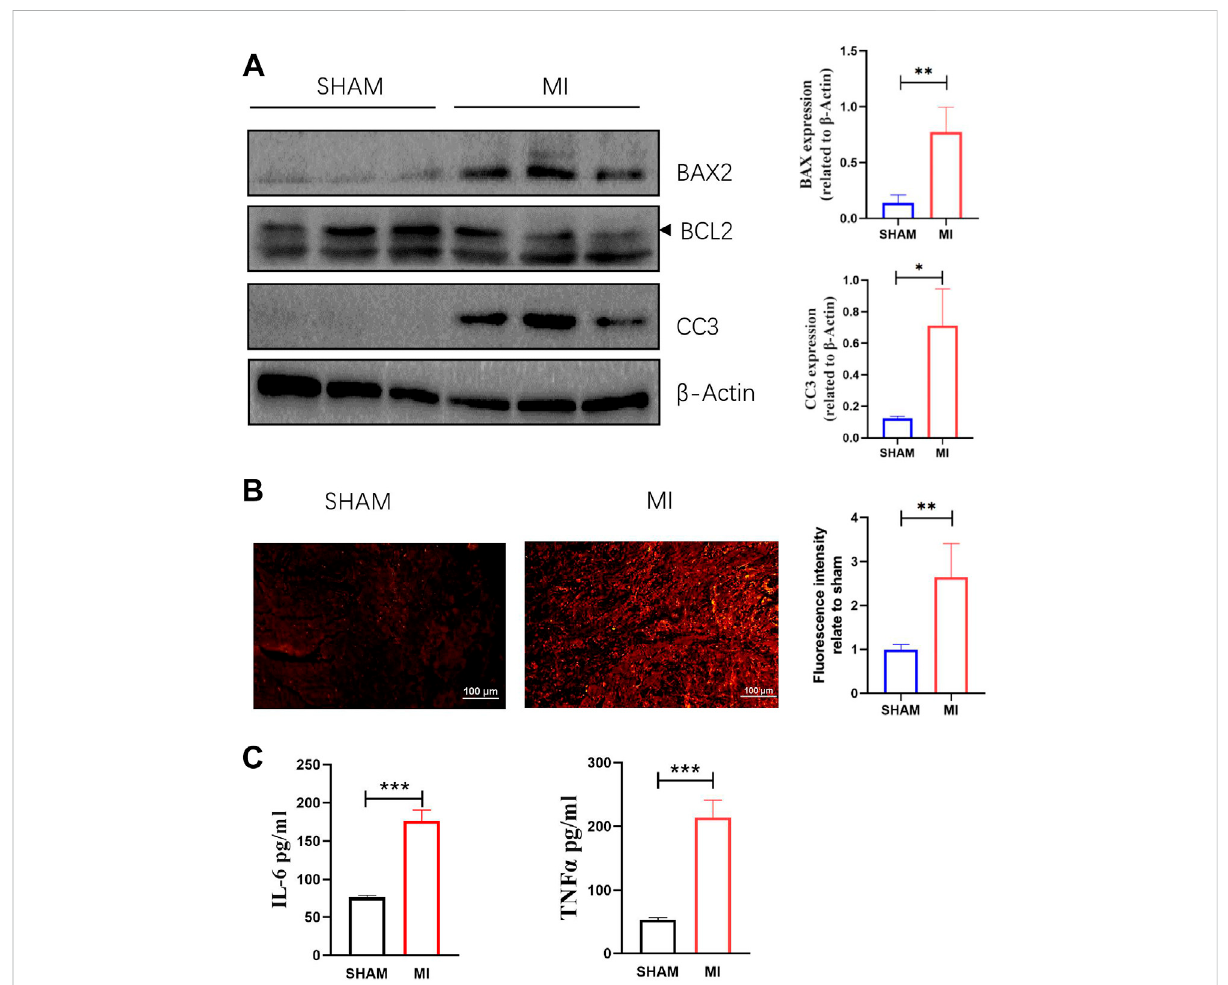
FIGURE 4 Apoptosis, ROSproductioninmyocardialtissue,andlevelsofTNF-aandIL-6inserum areincreased3 daysafterMI. (A) Westernblottingshows the relative protein intensities of BAX2, BCL2, and CC3 (mean ± SD, n = 3). (B) ROS fl uorescence intensity of frozen heart sections from mice in the SHAMandMIgroups(mean±SD, n =5). (C) ThelevelsofIL-6andTNF-ainserumofmiceintheSHAMandMIgroups(mean±SD, n =5).*, p < 0.05; **, p < 0.01; ***, p < 0.001; Scale bars: 100 μ